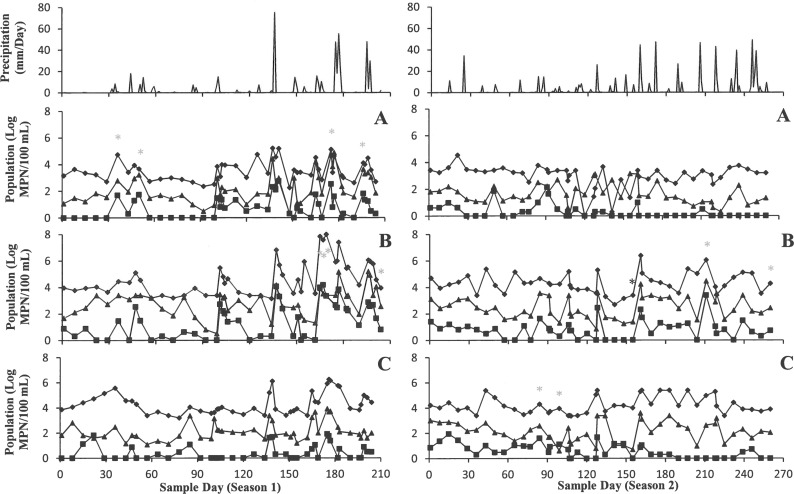
Most Probable Number of Total coliform (♦), Generic E. coli (■), and enterococci (▲) (Log MPN/100 mL) from six agricultural ponds (Pond 1: A, Pond 2: B, Pond 3: C) with daily rainfall (mm/Day) in Central Florida.invA positive sampling days were shown with “*”.